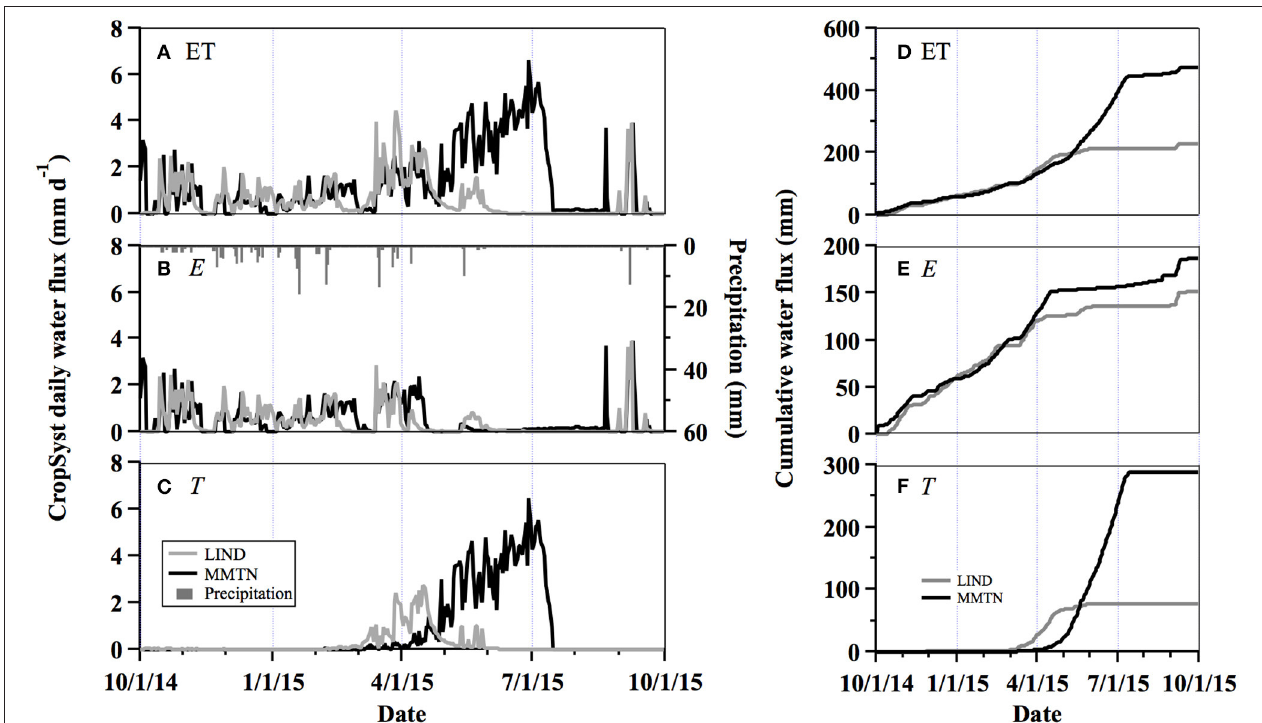
FIGURE 8 | CropSyst daily (A–C) and cumulative (D–F) evapotranspiration (ET), soil water evaporation ( E ), and crop transpiration ( T ) at the low-rainfall (LIND) and high-rainfall (MMTN) winter wheat fields during the water year of 2015. Daily precipitation data were only plotted for LIND.